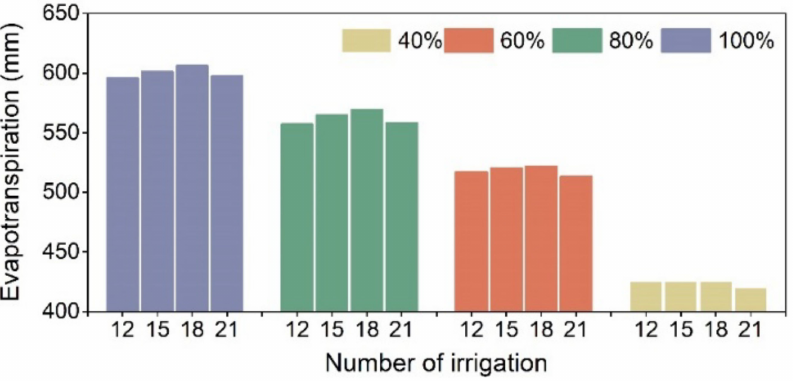
Figure 10. Simulation and comparison of total evapotranspiration under different irrigation